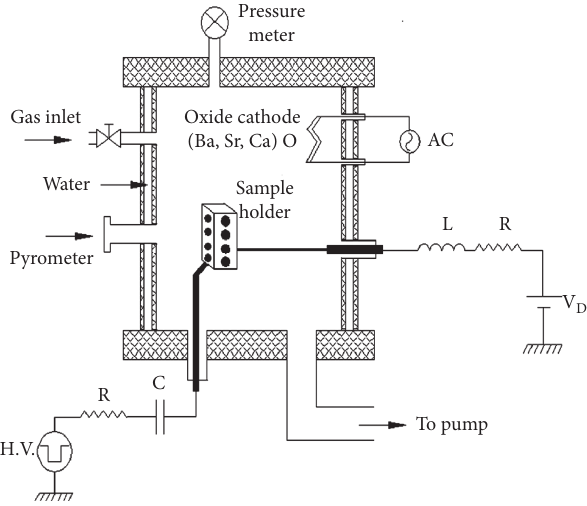
Figure 1: Schematic drawing of HT-NPBII